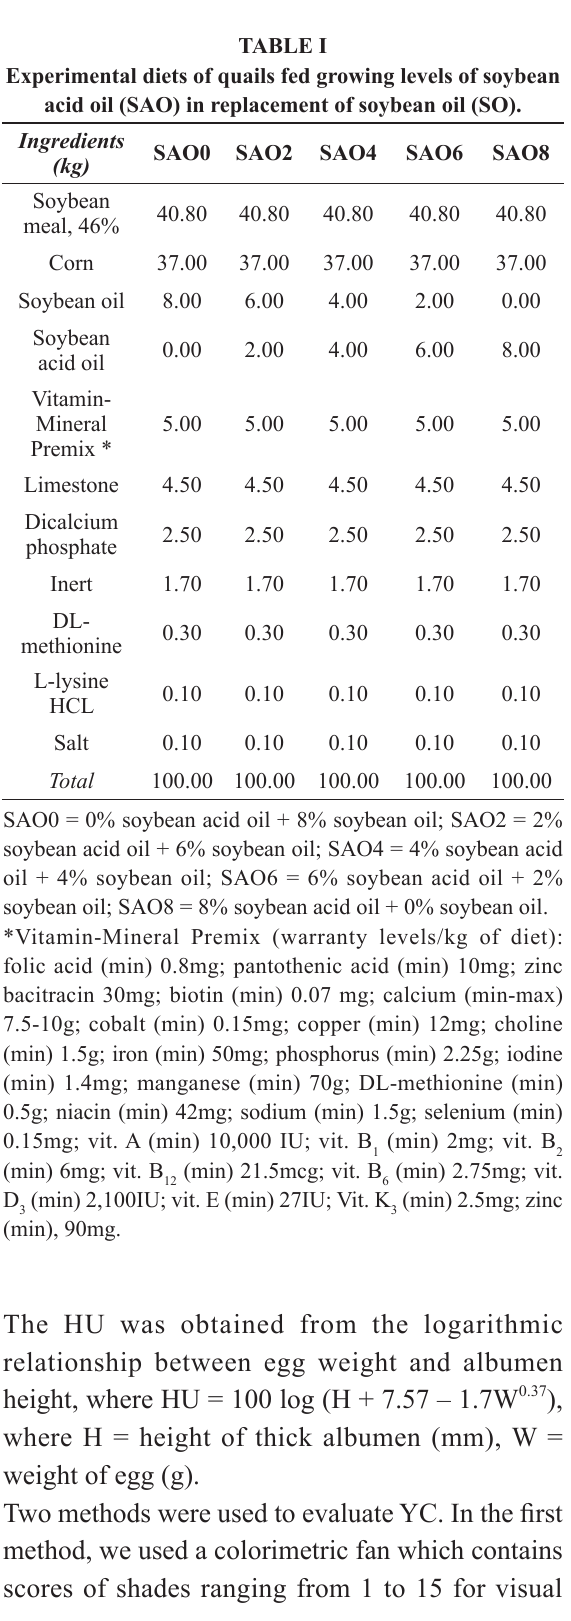
The HU was obtained from the logarithmic relationship between egg weight and albumen height, where HU = 100 log (H + 7.57 – 1.7W 0.37 ), where H = height of thick albumen (mm), W = weight of egg